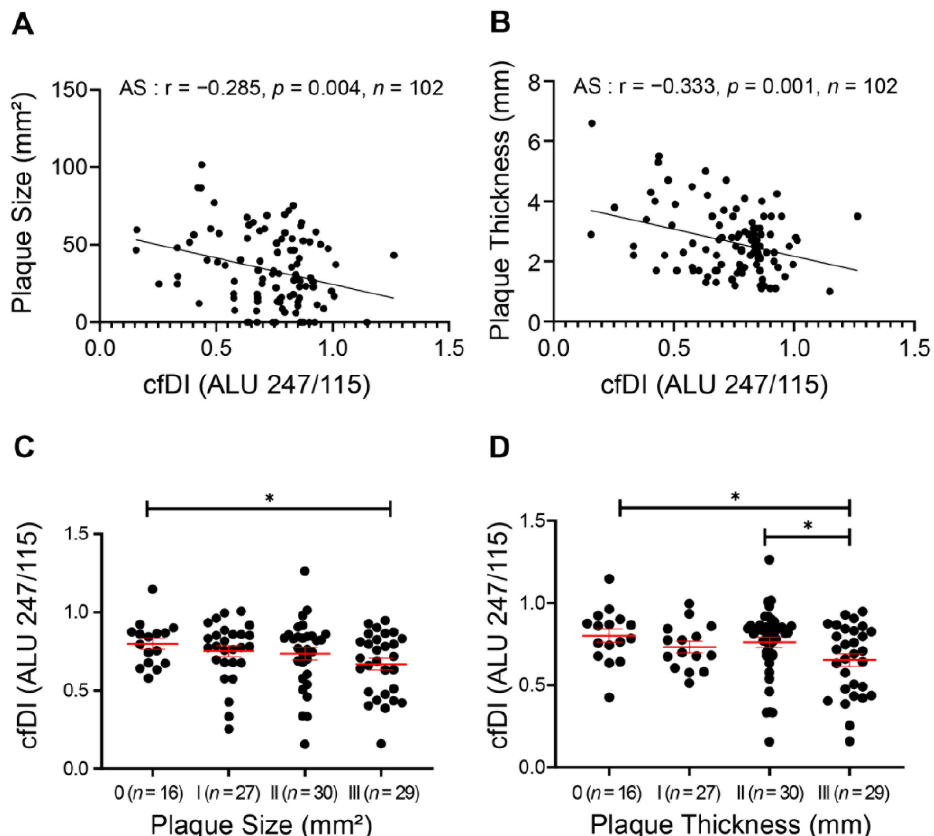
Figure 2. Reduced cfDI associates with the carotid plaque progression in atherosclerosis. ( A , B ) Spearman correlation coefficients for cfDI correlated with carotid plaque size (A), and carotid intima media thickness (CIMT) ( B ). (C,D) Levels of cfDI among different groups of carotid plaque size ( C ) and CIMT ( D ). Data are mean ± SEM. * p < 0.05. Table 1. Linear regression analysis of the association between cfDI and clinical factors adjusted by age and gender.